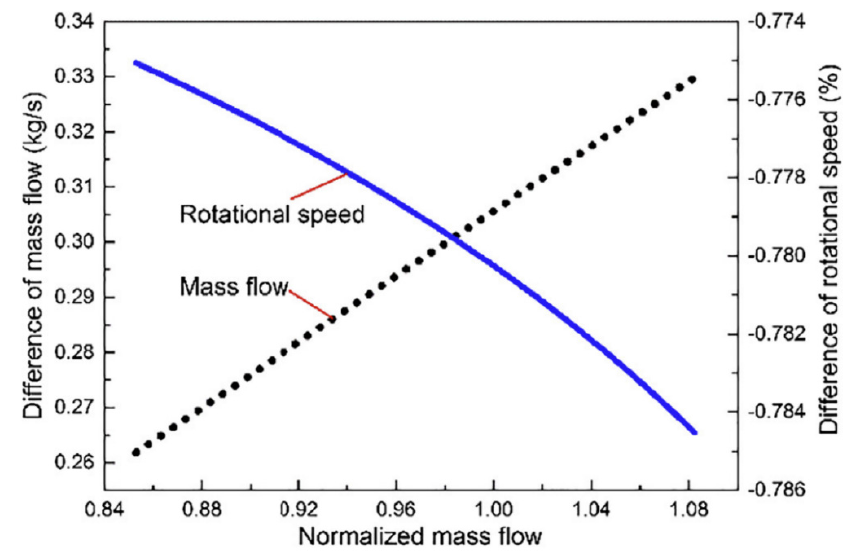
Figure 6. Differences between saturated humid and corresponding dry air (reprinted with permission from [135]).